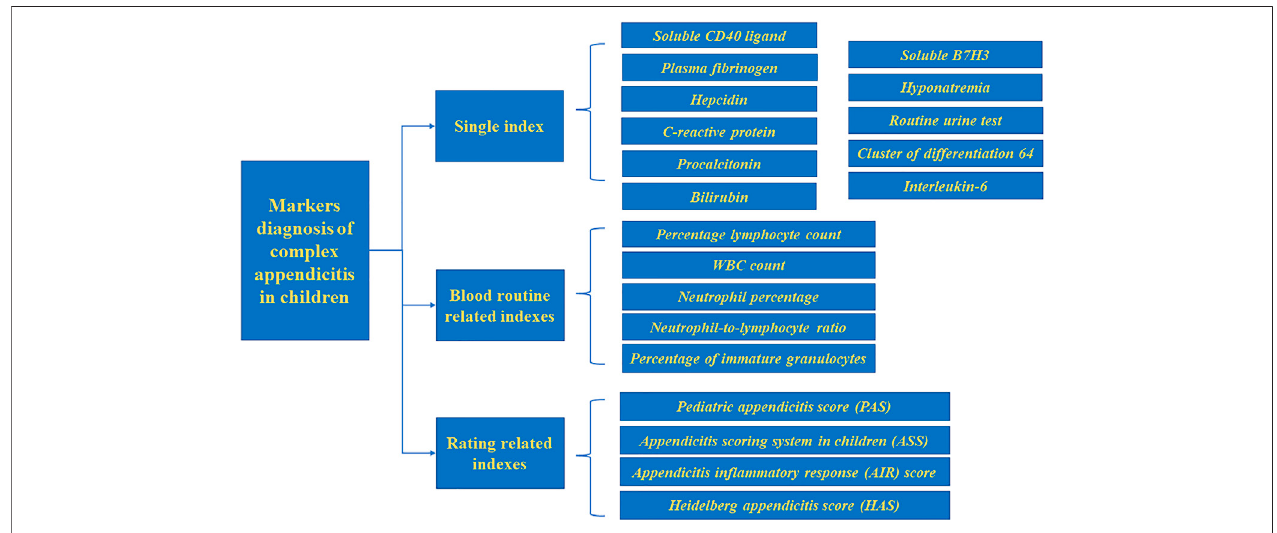
FIGURE 1 | Markers for pediatric complex